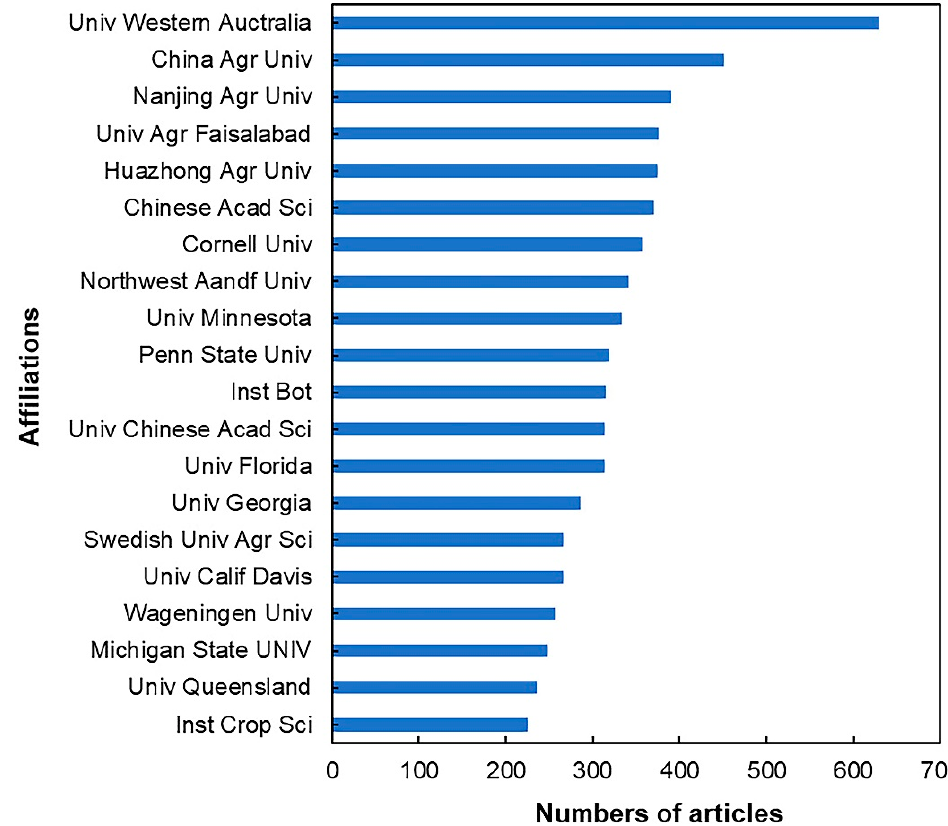
Figure 2. The top 20 affiliations by number of articles published from 2000 to 2021. The graph of the cooperation network of the top 30 countries by volume of publica- tions shows three kinds of clustering results among countries (Figure 5). Countries with larger nodes have more cooperative relationships with more countries and their degree of centrality and importance in the cooperative network is more significant. The USA is the center of the cooperative network for root traits research, with four major partners, namely China, Germany, Canada and Brazil. In addition to the USA, China and Germany also had good root traits research and carried out close cooperation and exchanges with other countries in the world. The thick line connections between the USA and other countries show that the USA has produced a large number of articles on international cooperation in the study of root traits. In addition to the USA, other major countries in the world have also expanded their cooperation networks. It was confirmed that the cooperation between developed countries guided the research direction of root traits, which also meant that international cooperation promoted the development of root traits